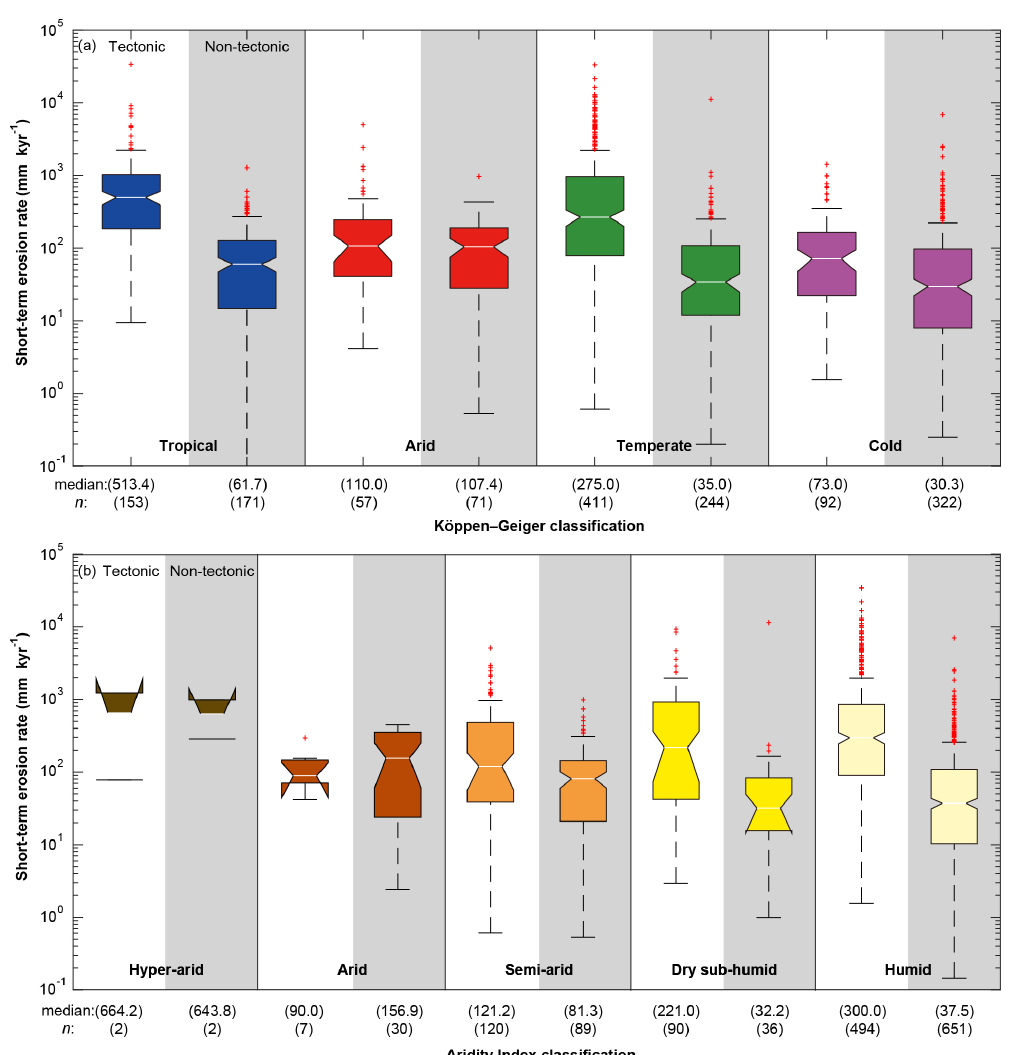
Figure A3. Short-term erosion rates classified by tectonic (white backgrounds) and non-tectonic regions (grey backgrounds) for climate zones of Köppen–Geiger climate classification (a) and Aridity Index classification (b) . Short-term erosion rates in tectonic regions are generally higher than in non-tectonic regions across all climate zones (except for the Arid category in the AI classification).